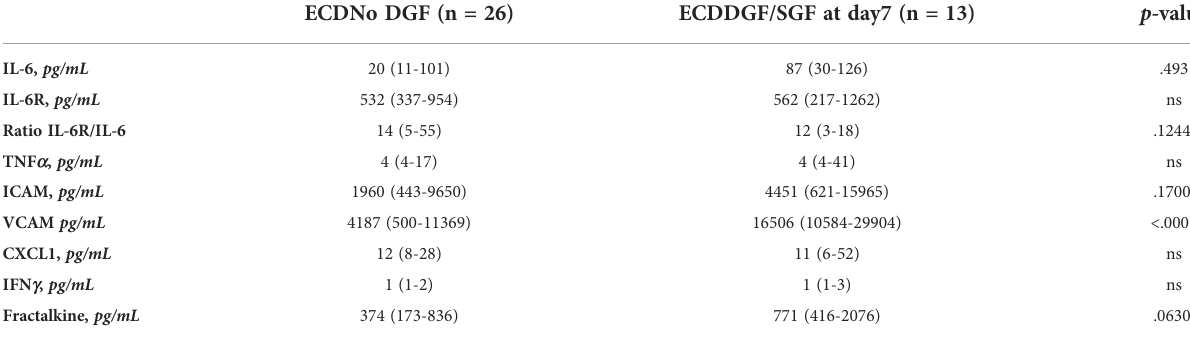
TABLE 3 In fl ammatory biomarker levels observed in the machine perfusion fl uid of ECD transplants and delayed/slow graft function. ECDNo DGF (n =